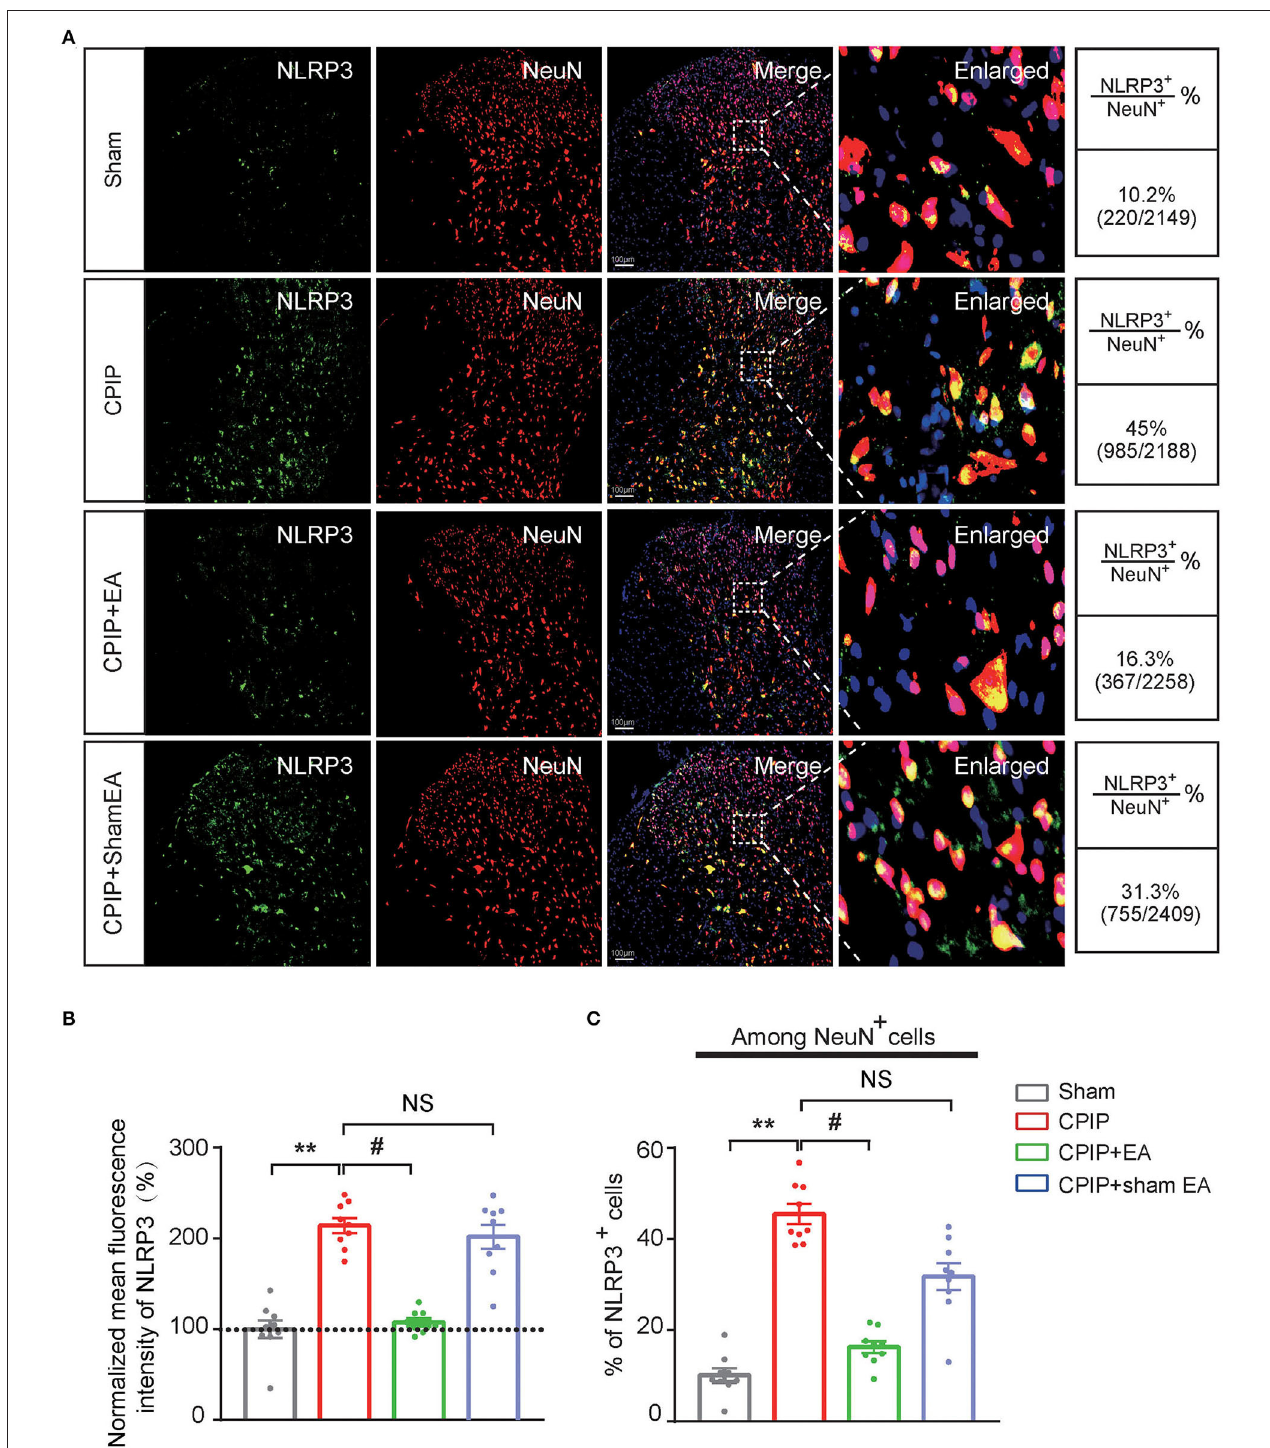
FIGURE 4 | EA intervention attenuates NLRP3 overexpression in spinal cord dorsal horn neurons. (A) Double immunostaining showing NLRP3 (in green) co-expression with the neuronal marker NeuN (in red) in ipsilateral spinal cord dorsal horn of CPIP rats under different treatment conditions. DAPI (in purple) was used as counterstain. Quantification is illustrated on the right of the panels. (B) Summary of the mean fluorescence intensity of NLRP3. All intensities were normalized with the value of sham group. (C) Summary of the percentage of NLRP3 + cells among all NeuN + cells. ** p < 0.01 vs. Sham group. # p < 0.05 vs. CPIP group. NS, no significance vs. CPIP group. Scale bar indicates 100 µ m. Data were obtained from 9 rats/group. One-way ANOVA with Tukey’s post-hoc test was applied in (B,C) .